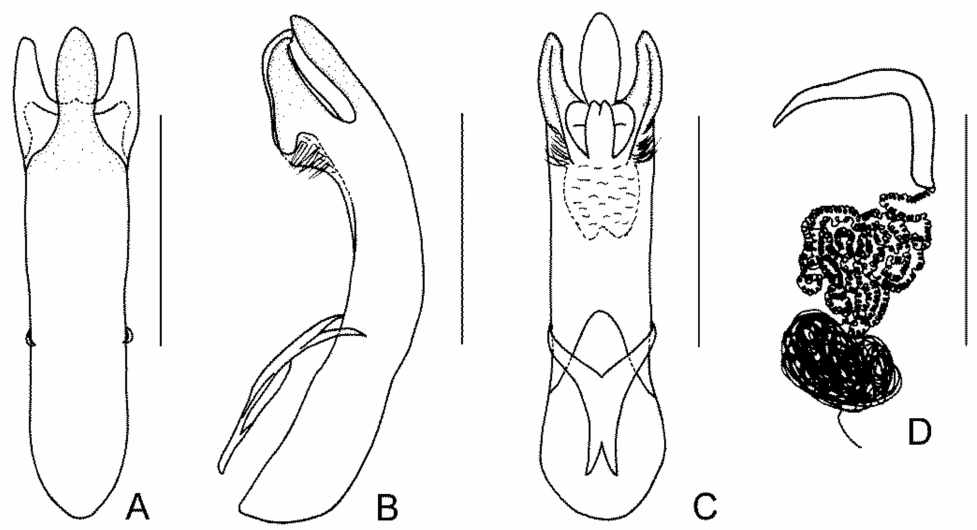
Figure 14. Cryptocephalus ( Burlinius ) confusus Suffrian, 1854: ( A ) dorsal view of aedeagus; ( B ) lateral view of aedeagus; ( C ) ventral view of aedeagus; ( D ) spermatheca. (Scale bars: 0.5 mm). The material examined was from CHINA, Beijing: two females, Baihuashan, 6.VII.1972,